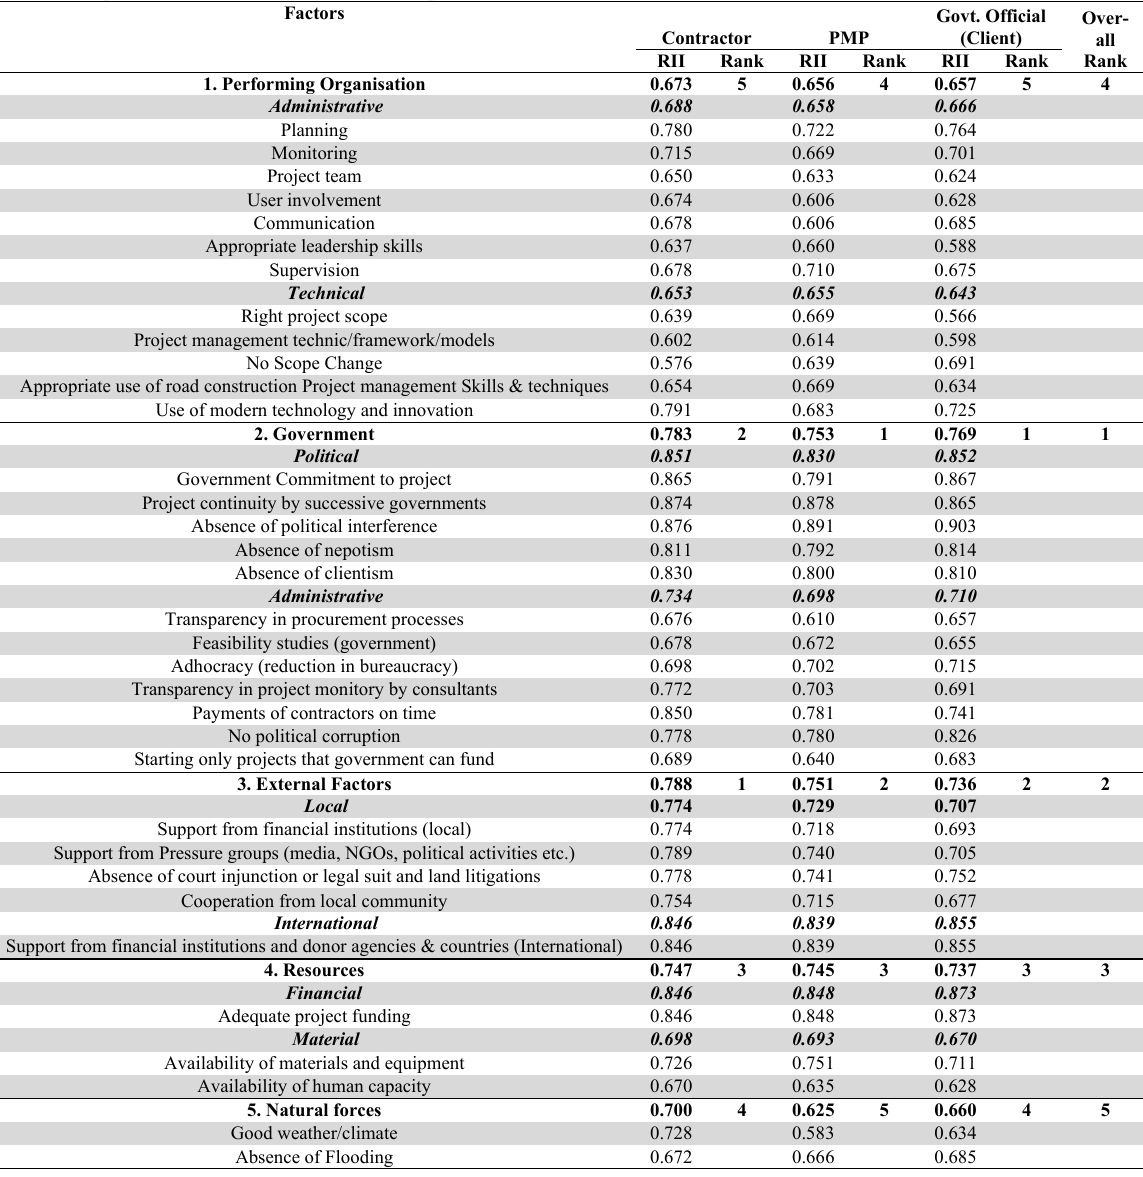
Table 3 Relative Importance Index and Ranks of Group of Factors